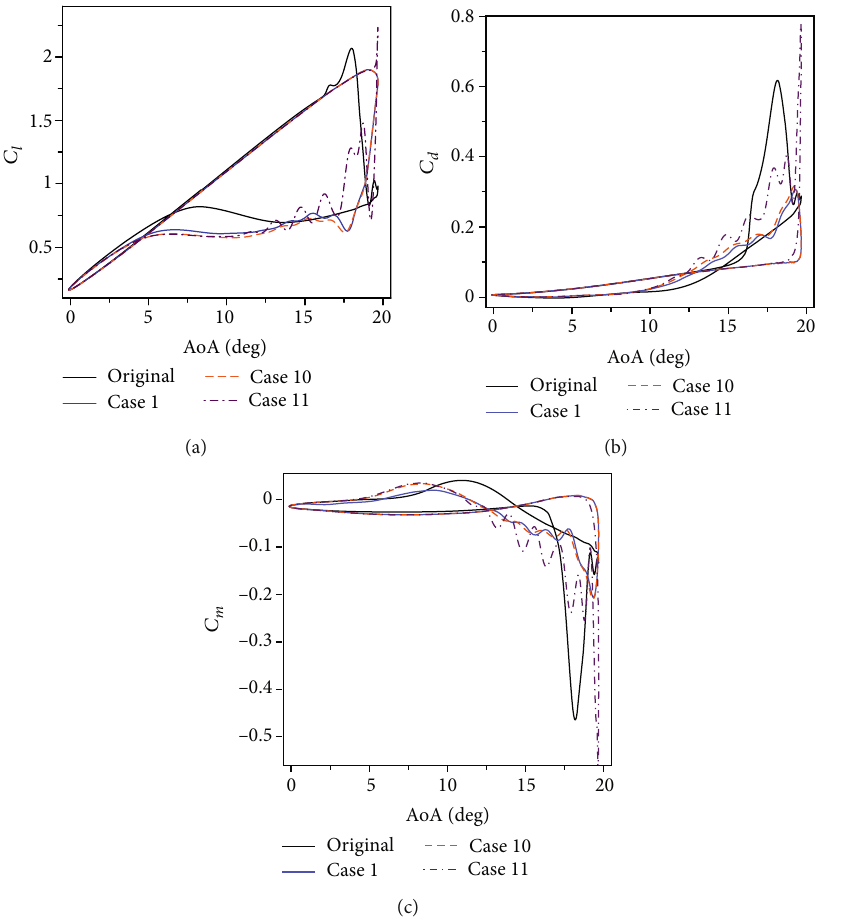
Figure 37: Comparison of aerodynamic coe ffi cients for Cases 1, 10, and 11: (a) lift coe ffi cients, (b) drag coe ffi cients, and (c) pitching moment coe ffi